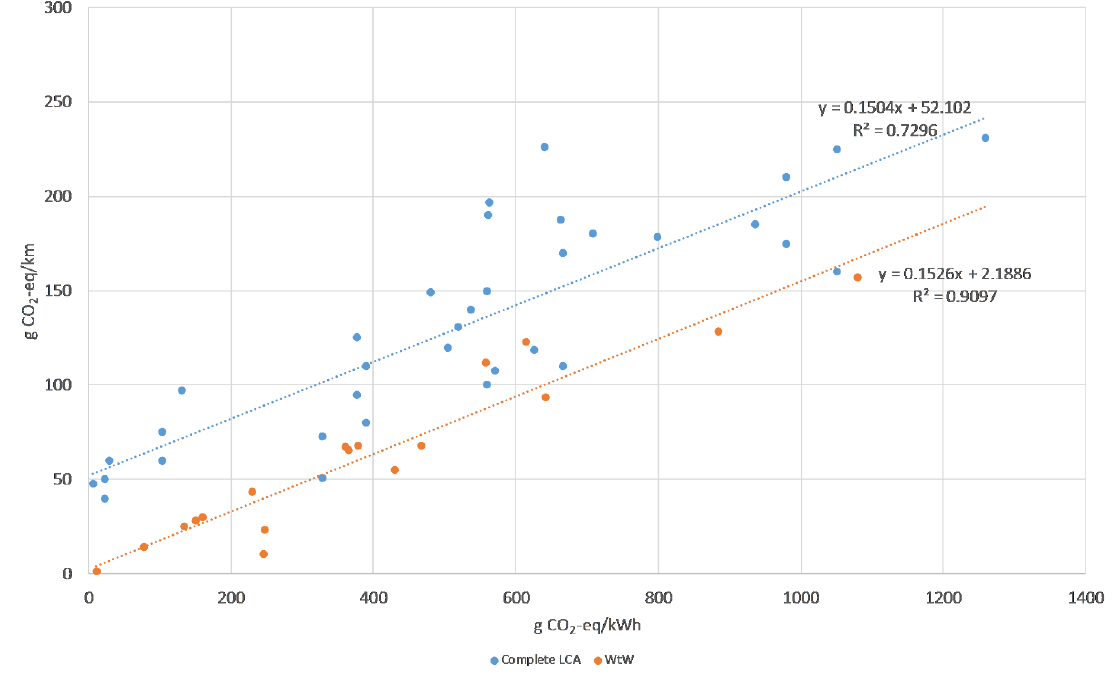
Figure 10. Linear regression between passenger-EVs climate change and GHG emission intensity of the electricity mix used to recharge them, divided between WtW analysis and complete LCA studies.